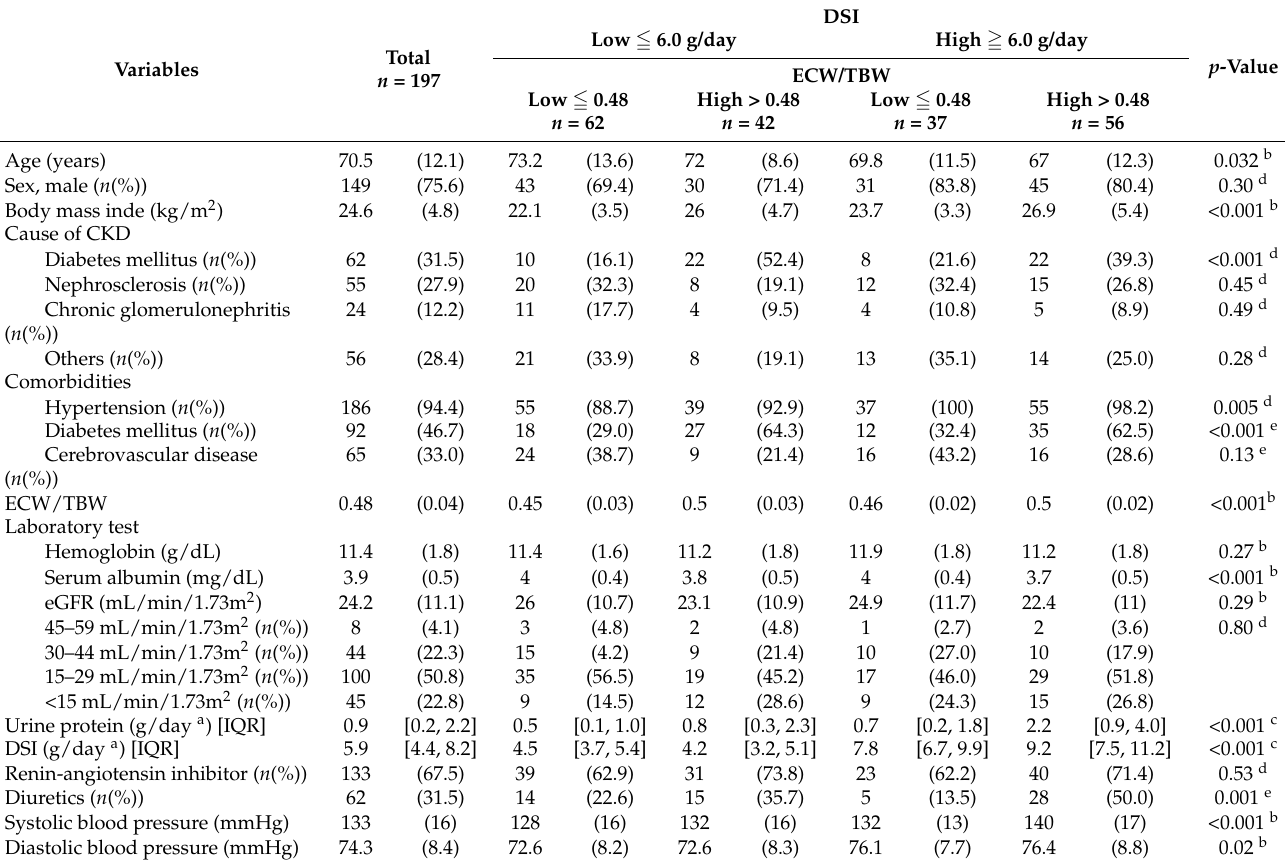
Table 1. Baseline characteristics.